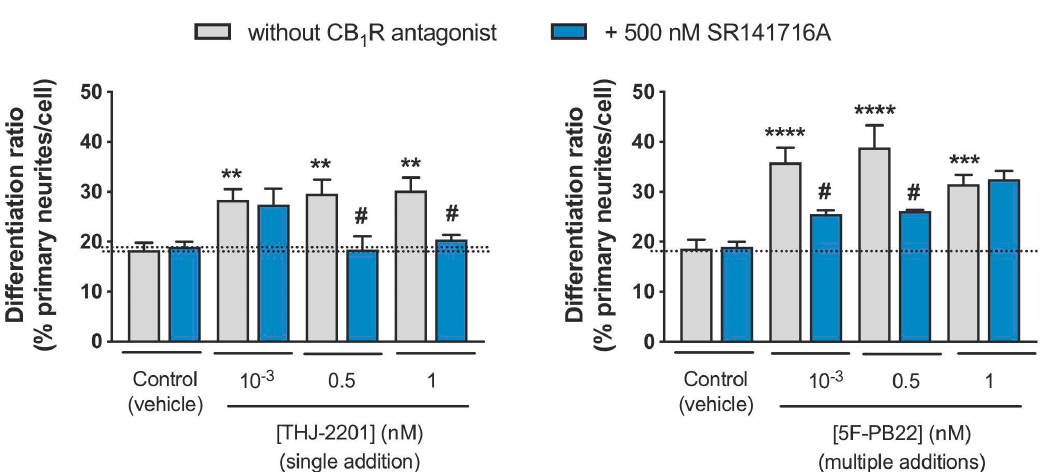
Figure 6. Assessment of CB 1 receptor (CB 1 R) involvement in SC-mediated neuronal di ff erentiation. Neuronal di ff erentiation was induced as described in Materials and Methods and NG108-15 cells were treated with 5F-PB22 or THJ-2201 in the conditions that previously showed significant changes in primary neurite outgrowth (grey bars), following exposure 500 nM SR141716A, a selective CB 1 R antagonist (blue bars). Each bar represents the mean ± SEM, for at least five independent experiments, performed in duplicate. ** p < 0.01, *** p < 0.001, **** p < 0.0001, compared to vehicle control (one-way ANOVA, followed by Dunnett’s post-test). # p < 0.05, compared to the respective SC concentration in the absence of antagonist (one-way ANOVA, followed by Sidak’s multiple comparisons test).